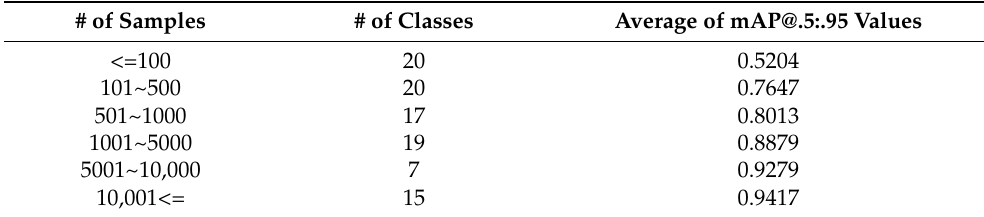
Table 9. Recognition performances of each cluster based on the number of samples. # of Samples